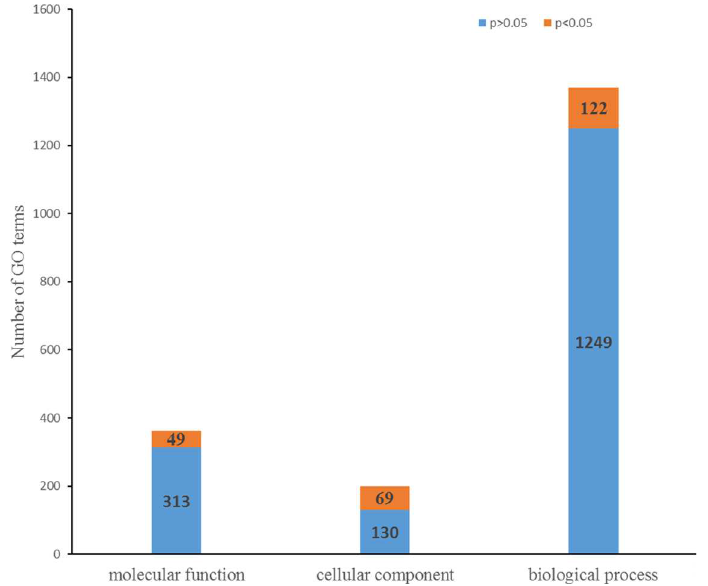
Fig 4. The GO enrichment analyses of the differentially abundant proteins in PA2 vs . PA4. P value < 0.05: GO terms were significantly